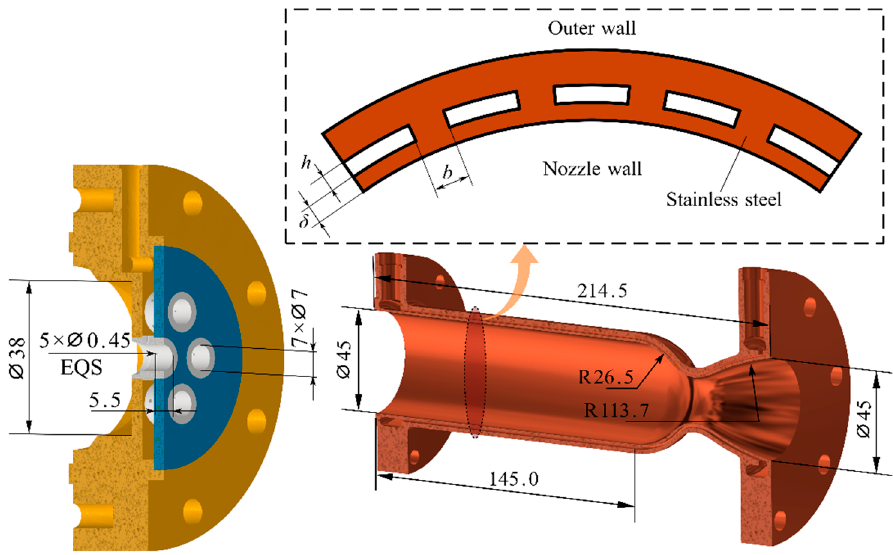
Figure 2. Structure of the injector and the thrust chamber.